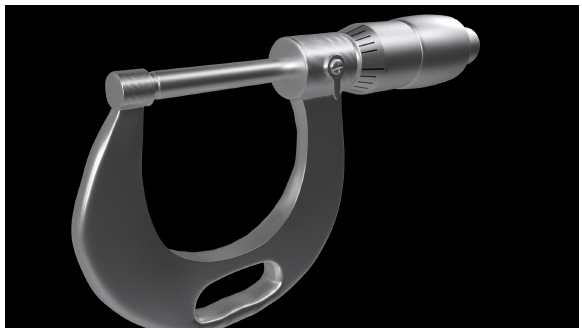
Figure 1. Three-dimensional model of an outside mechanical